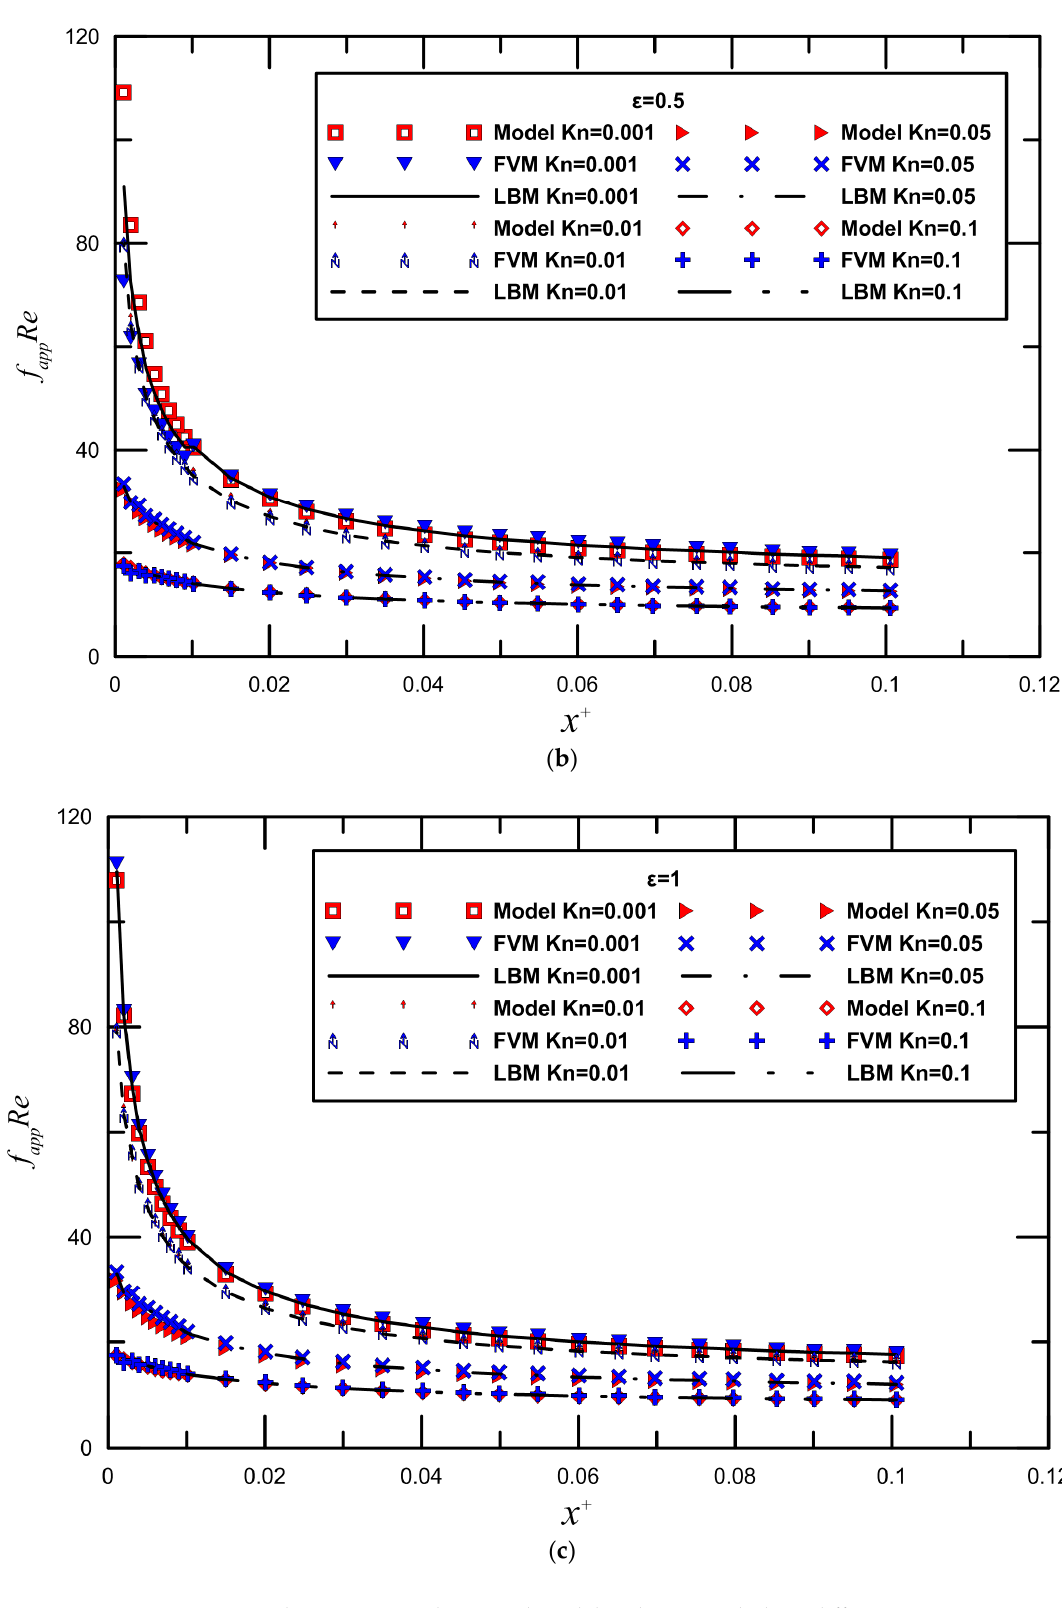
Figure 3. Comparisons between semi-theoretical model and FVM with three different aspect ratios.